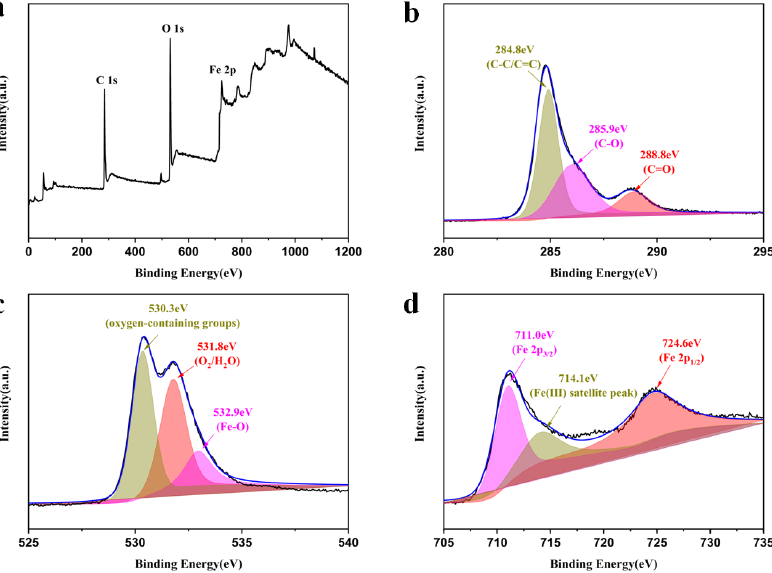
Figure 4. XPS spectra: ( a ) survey scan, ( b ) C 1s spectrum, ( c ) O 1s spectrum, and ( d ) Fe 2p spectrum of MrGO-2.